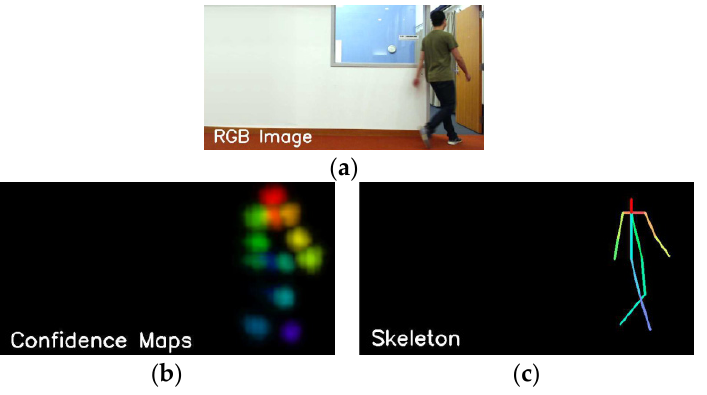
Figure 4. Human Skeletons were generated by FMCW [67]. ( a ) is a ground-truth image that was captured by the camera; ( b ) presents the confidence maps of key points generated by RF signals; ( c ) is the human skeleton that was generated according to ( b ).